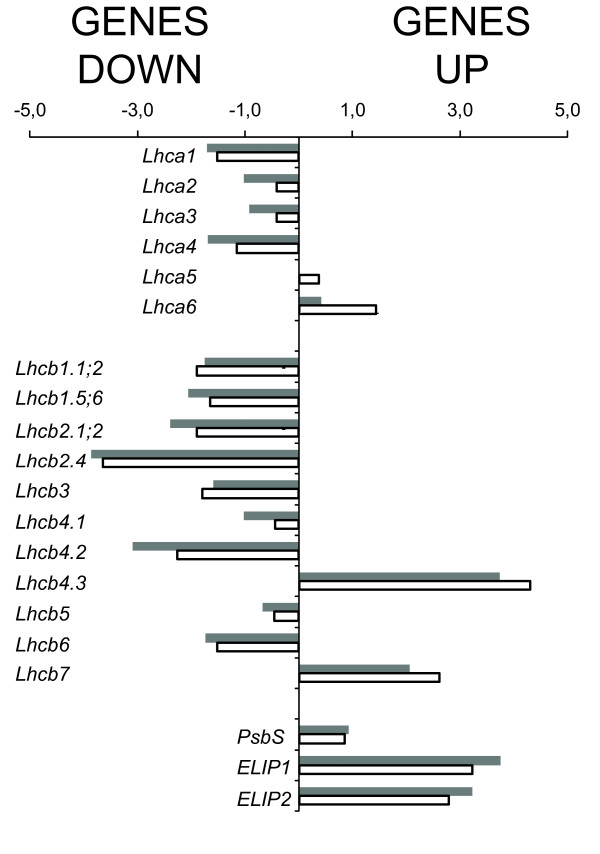
Lhc gene expression. Light harvesting complex (Lhc) gene expression after 24 h stress (1000 μmol photons m-2 s-1, 10°C) in wild-type (gray bars) and npq1lut2 (white bars) plants. For each sample, the average of three repetitions was used to calculate the fold change, which is expressed using the log2 scale. The genes significantly down-regulated after RMA analysis are Lhca1 (251814_at), Lhcb1 (255997_s_at; 267002_s_at), Lhcb2 (263345_s_at; 258239_at), Lhcb3 (248151_at), Lhcb4.2 (258993_at), Lhcb6 (259491_at). The genes significantly up-regulated after RMA analysis are Lhcb4.3 (265722_at), Lhcb7 (259970_at), ELIP1 (245306_at) and ELIP2 (258321_at). Lhca4 (252430_at) was significantly down-regulated only in the wild-type plants whereas Lhca6 (256015_at) was significantly up-regulated only in the mutant plants.